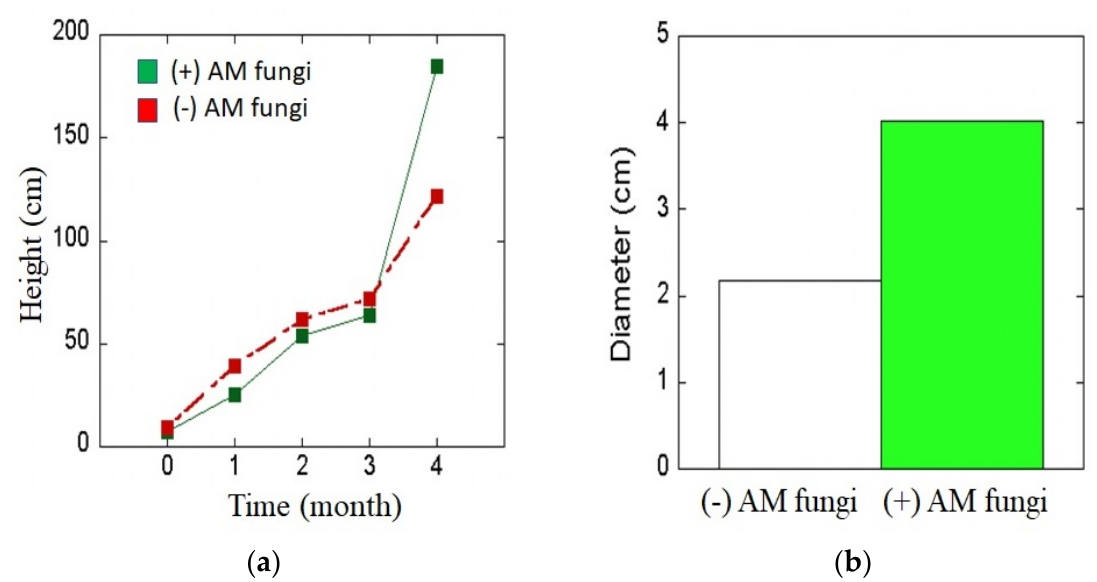
Figure 9. Reforesting post-coal-mining using Sesbania grandiflora inoculated with Arbuscular Mycorrhizal (AM) fungi and without AM fungi: ( a ) shoot height 1 to 4 months after transplanting, ( b ) diameter 4 months after transplanting [150]; (the histogram has been modified).